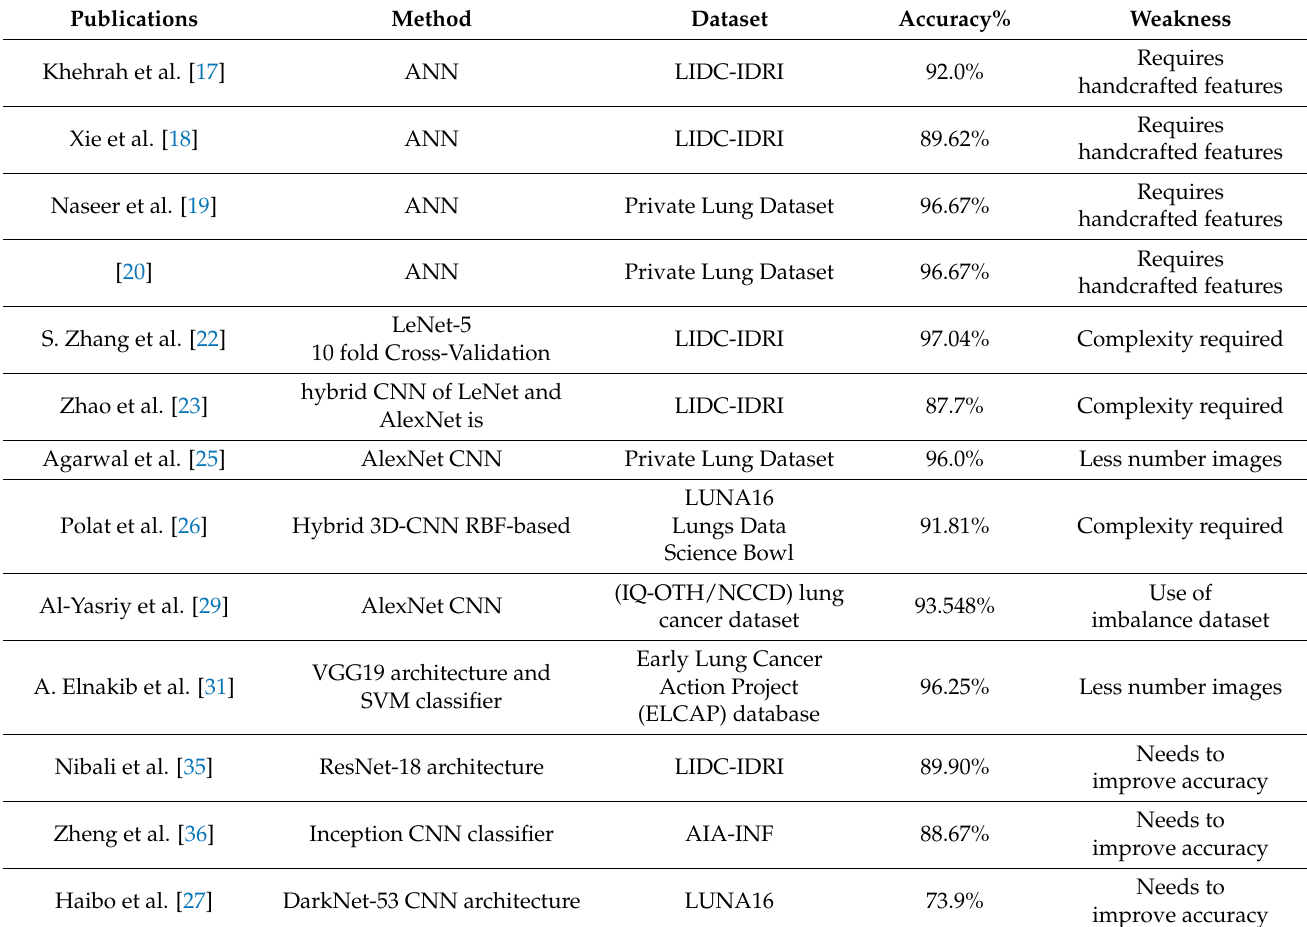
Table 1. Literature survey on computational intelligence-based lung cancer detection